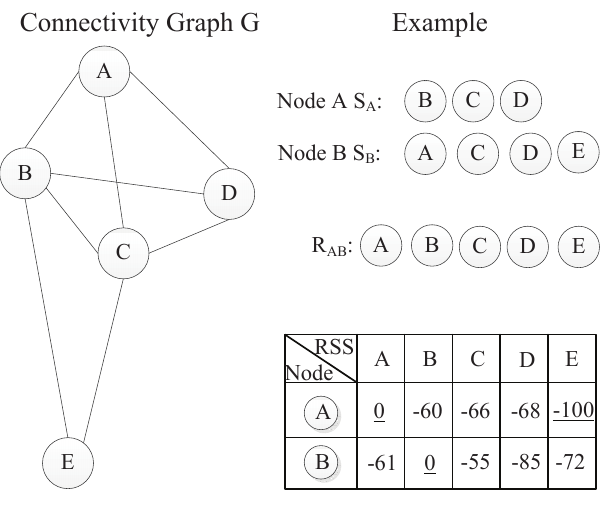
Figure 2. The calculation process of RSSI